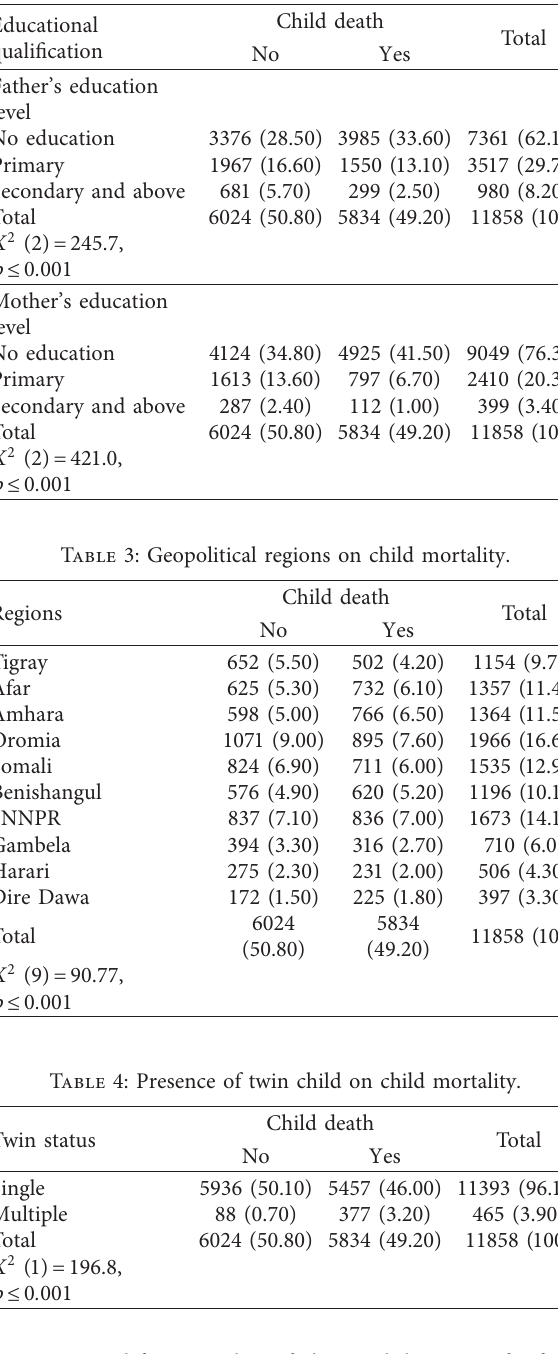
Table 2: Parent’s education qualification on child mortality.